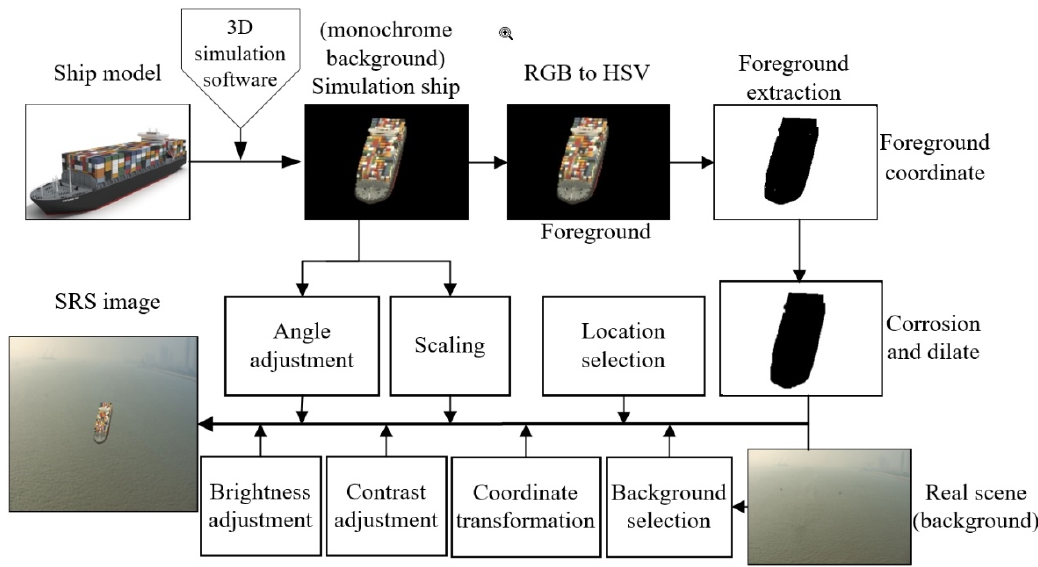
Figure 6. Flow chart of image superimposition.